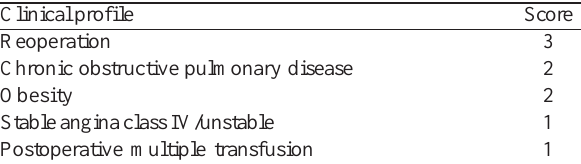
Table 1. Factors associated with development of mediastinitis after CABG surgery and MagedanzSCORE Clinical profile